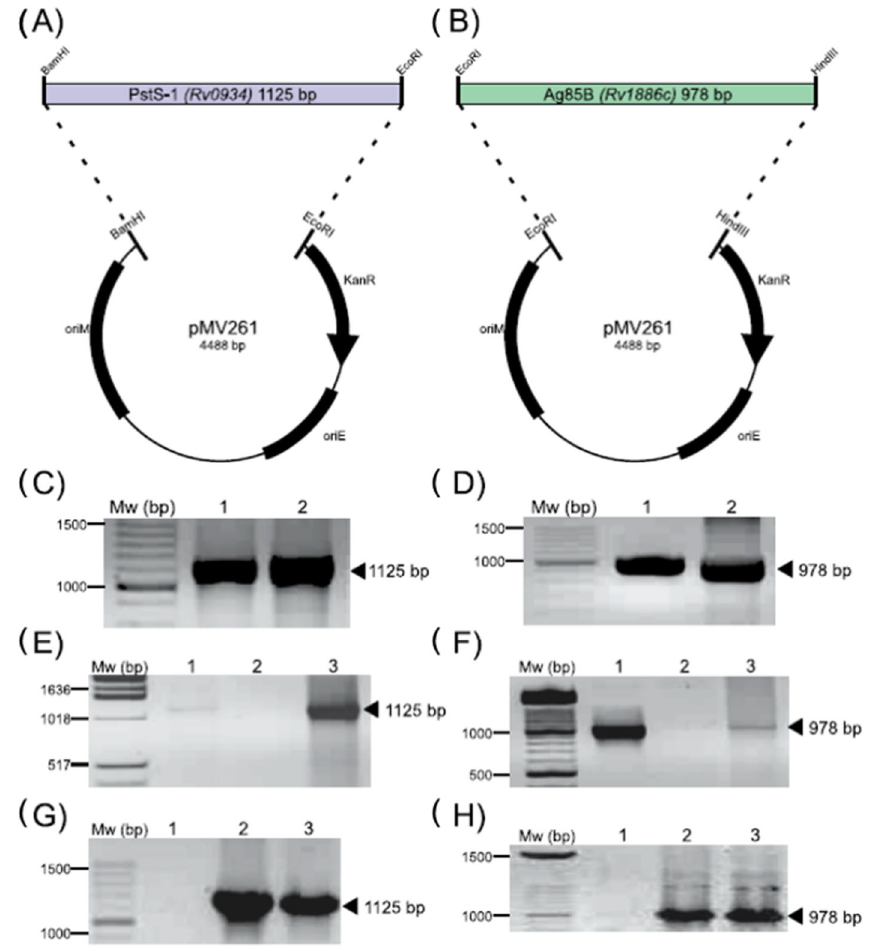
Figure 1. Plasmid design and construction of ( A ) pMV261-Rv0934 for PstS-1 and ( B ) pMV261-Rv1886c for Ag85B. ( C , D ) PCR amplification of Rv0934 and Rv1886c, respectively, from M. tuberculosis (lane 1) and M. microti (lane 2). ( E , F ) PCR amplification of Rv0934 and Rv1886c from plasmid isolated from E. coli colonies after transformation with pMV261-Rv0934 and pMV261-Rv1886c, respectively (lane 3); controls (lanes 1 and 2, respectively). ( G , H ) PCR amplification of Rv0934 and Rv1886c from plasmid isolated from M. microti colonies transformed with pMV261-Rv0934 and pMV261-Rv1886c, respectively (lane 3); controls (lanes 1 and 2). Black arrows indicate the expected amplicon size.